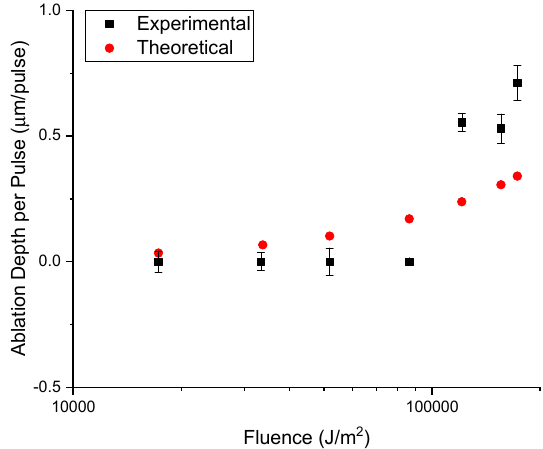
Figure 9. Comparison of theoretical and experimental ablation depth for a range of fluences in silicon.